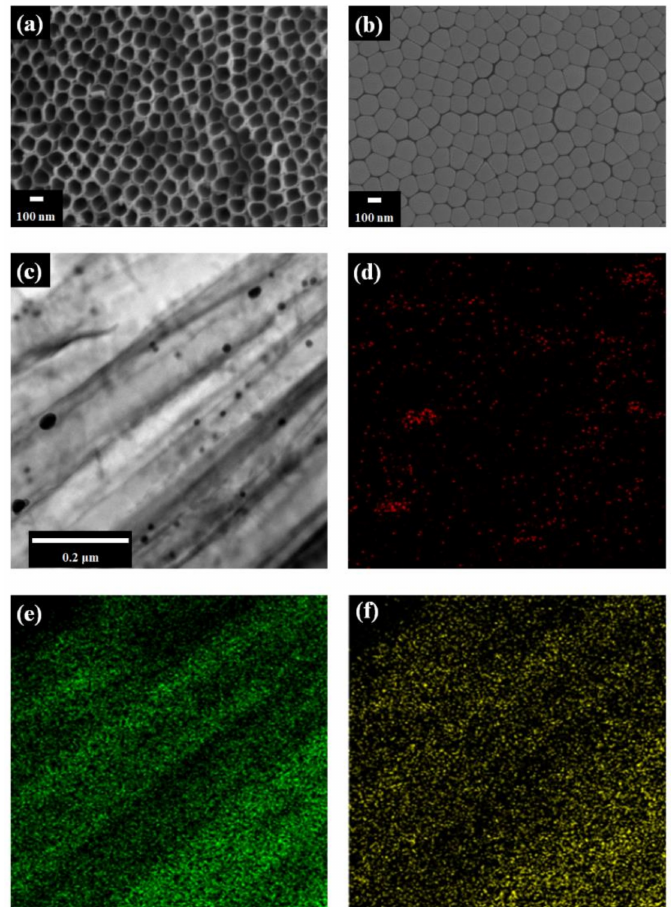
Figure 2. FE-SEM and Cs-FE-TEM images. ( a ) Top of TNTAs and ( b ) bottom layer of freestanding TNTAs by FE-SEM. ( c ) Au NPs by Cs-FE-TEM. Illustrations ( d ), ( e ), and ( f ) are the elemental mappings of Au, Ti, and